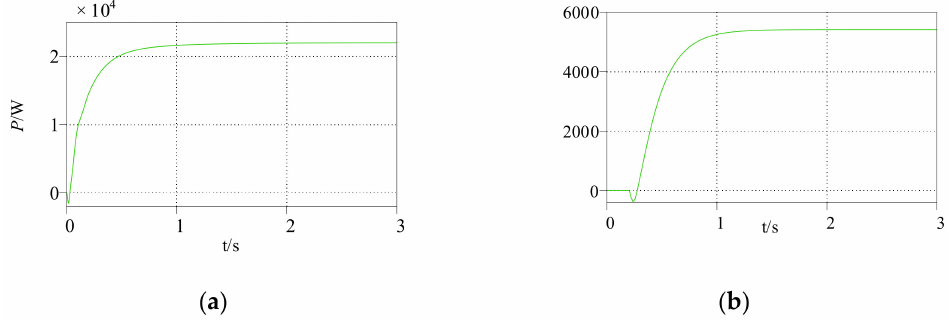
Figure 6. ( a ) Active power of a GFM converter ( P set = 22,000 W, SCR = 4.84); ( b ) reactive power of a GFM converter ( P set = 25,000 W, SCR = 4.84).